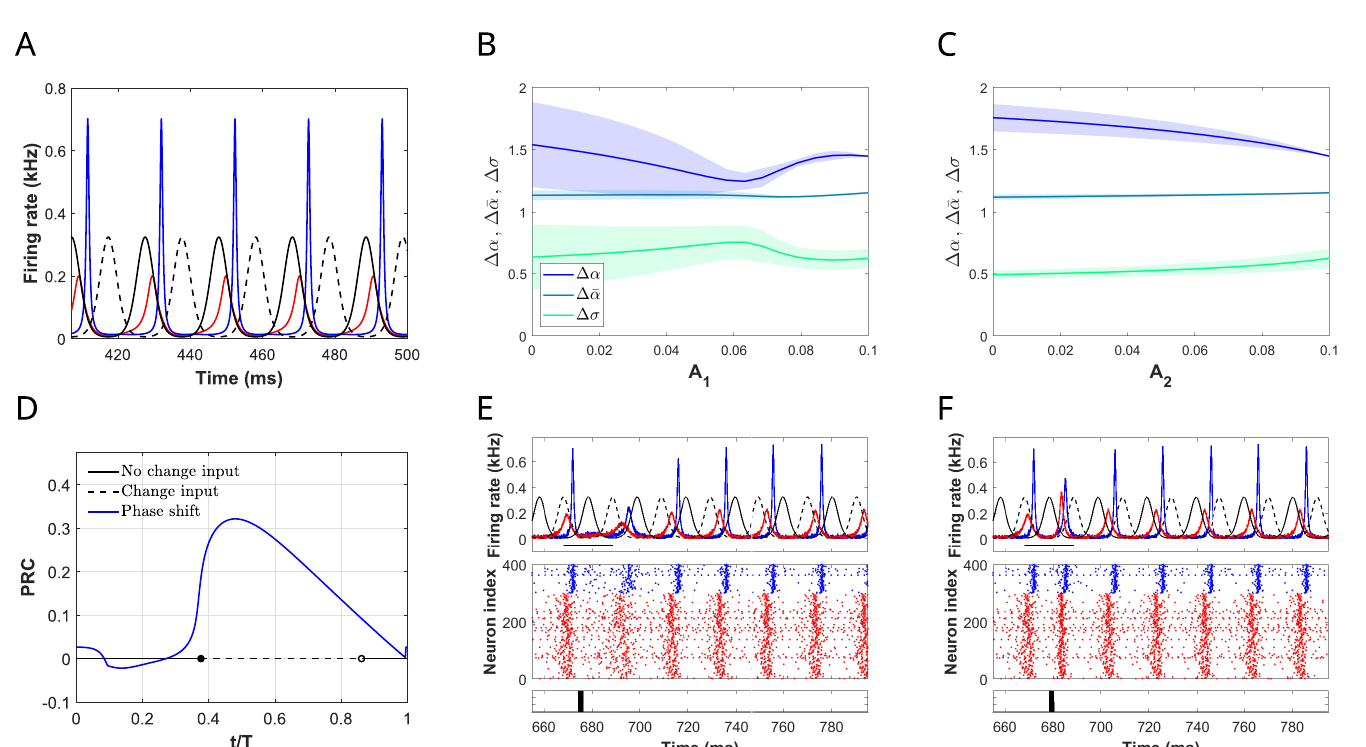
Fig 8. Selective communication and switching between attended stimulus. (A) Time evolution of the excitatory and inhibitory firing rate r respectively for system (1)-(2) receiving two identical inputs of von Mises type in antiphase ( κ 1,2 = 2 and T = T 1,2 = 0.84 T � , A 1,2 = 0.1). We establish that the closest input volley to the E-volley corresponds to the primary input (black solid curve), and the other one to the distractor (black dashed curve). (B, C) Factors Δ α , Δ σ and D � a describing changes in the E-cell evoked response (B) when the amplitude of the primary A 1 is varied from 0.1 to 0 while keeping the amplitude of the distractor fixed at A 2 = 0.1 and (C) viceversa. We have computed the mean and standard deviation of these factors over 10 cycles of the primary input. (D) Phase Response Curve (solid blue) obtained by applying square-wave perturbations of amplitude 1.5 and duration 2 ms at different phases of the periodic solution in panel A. The plot also shows if the (entrained) oscillator remains in the same periodic solution before and after the pulse administration (black solid line) or if the oscillator switches to a different solution where the roles of the primary and distractor are exchanged (dashed black line). (E, F) Simulations of the full spiking QIF model showing the response of the network to a square-wave current delivered at two different phases of the cycle: (E) t / T = 0.3, for which no switching between attended stimuli occurs, and (F) t / T = 0.5, for which switching occurs. Each panel shows (from top to bottom), for a time interval of 150 ms, the two identical von Mises inputs in antiphase (solid and dashed black) with the mean firing rates of the E-cells (red) and I-cells (blue) of the full spiking QIF model, the corresponding raster plot and the time at which the square-wave pulse is applied. We have integrated the full network of QIF neurons for 1000 ms. At time 200 ms we apply the two inputs of von Mises type. The square-wave pulse is applied at time 200 + 23 T + t